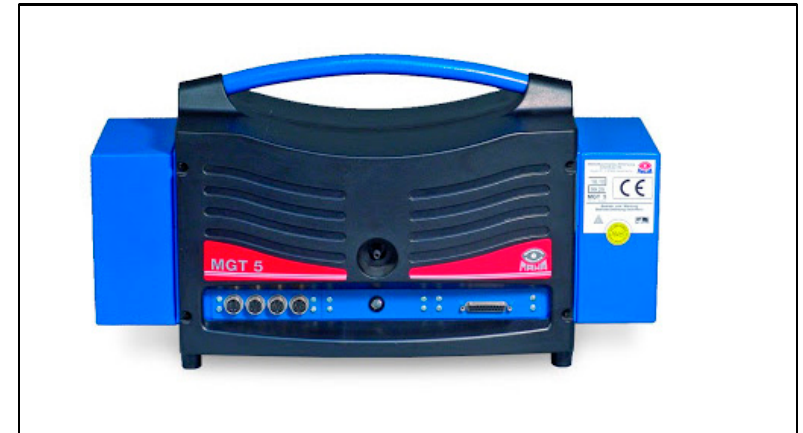
9 of 24 Figure 5. Schematic representation of the performed measurement. It is necessary to state that the chosen measuring technique is not primarily intended for the purposes of obtaining a specific measurement. Compact instruments (PEMS) are currently being developed for this type of measurement (RDE). They can record the data and then provide the required values directly without the need for any adjustments. This means that no synchronization of the recorded data or the connection of other measuring technology are required. The PEMS measuring device contains all of the necessary sen ‐ sors. During our measurements, we were able to replace such a measuring device, but after the measurements, it was necessary to work with the measured data and to adjust them in the next steps. After examining the current market offers in the field of PEMS equipment, the authors found that the price of such equipment ranges from EUR 91,000 (Cubic—Ruiyi, China) to EUR 150,000 (Senzors—Germany). Of course, these price offers are not available on the Internet, and as part of the research, we approached selected com ‐ panies [internal data provided on request]. 3.1. MAHA MGT 5 Exhaust Gas Analyzer A low ‐ current emission tester Maha MGT 5 (Figure 6) without a display (basic unit) was used for HC, CO, CO 2 , and O 2 analysis with lambda calculation. Basic exhaust gas analyzer technical data are in Table 2. In our case, the analyzer was also supplemented with a NO X sensor, which are not normally mounted in these devices. The analyzer is primarily intended to measure the emissions of a stationary vehicle (for example, when performing an emission inspection). The device is regularly calibrated in accordance with